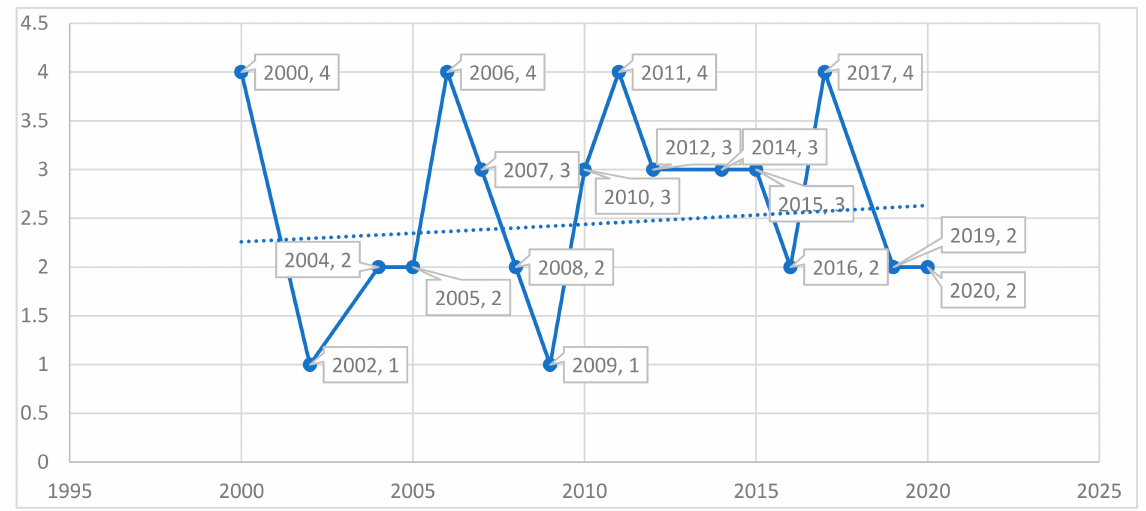
Figure 3. Chronological distribution of the primary